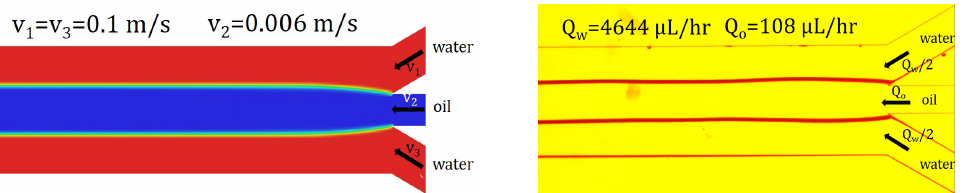
Figure 14. Experimental interfaces—qualitative validation of the numerical simulation using flow visualization. The input flow rates in the experiments correspond to the average velocities magnitude imposed in the numerical simulations.